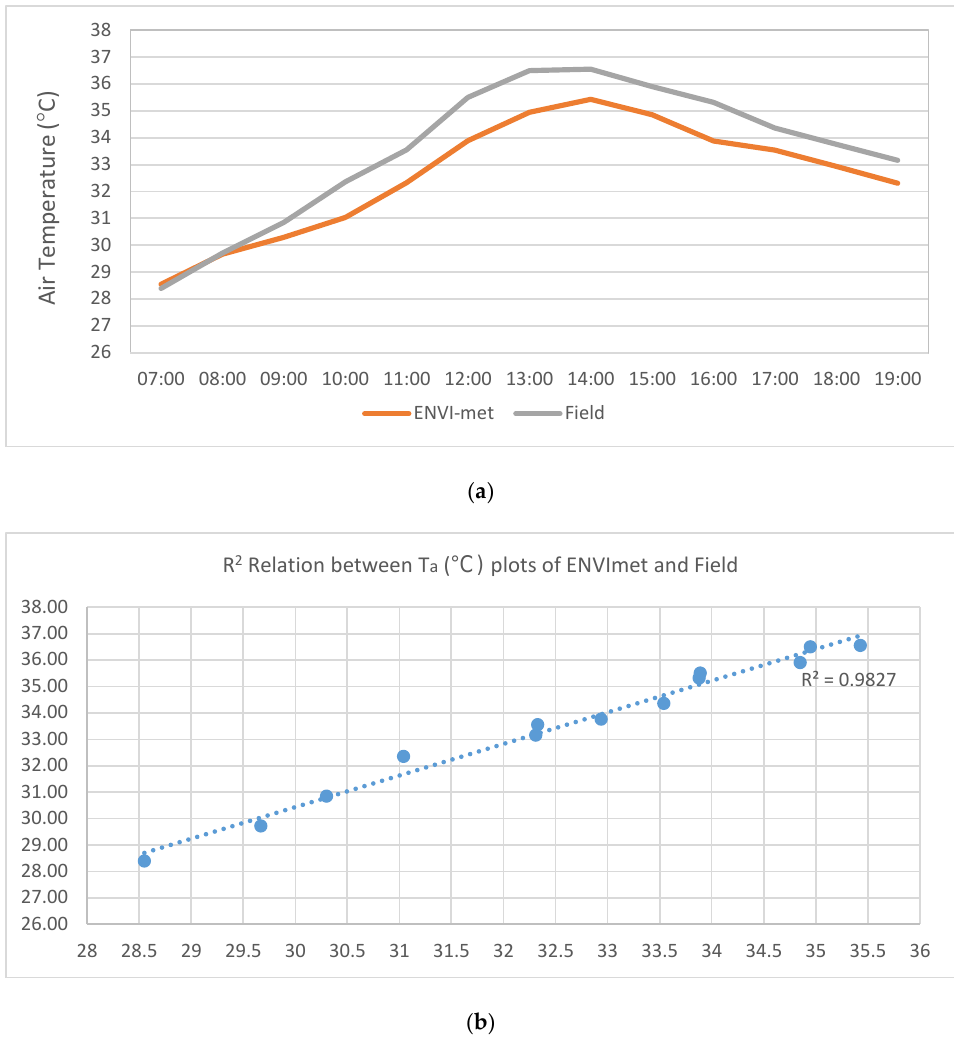
Figure 6. (a) Comparison between air temperature results of ENV-met and Field measurements. (b) R 2 Relation between air temperature (°C) plots of ENVI-met and Field measurements.